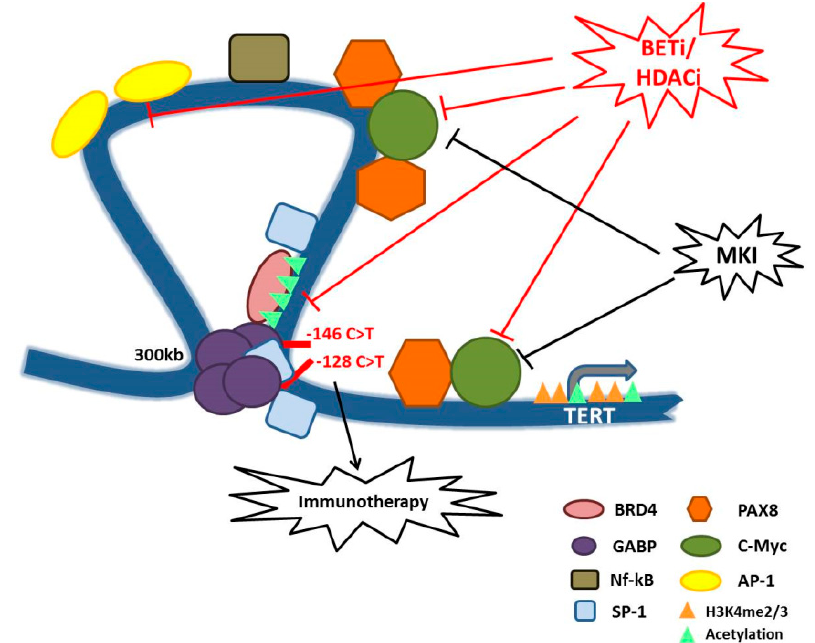
Figure 1. Schematic model representing TERT promoter regulation in TCs and some hypotheses of therapeutic interventions. The figure shows the long-range chromatin interaction mediated by GABP factors and BRD4 on the mutated TERT promoter, and all the transcription factors positively influencing TERT expression and for whom we described a possible connection with TERT promoter in TCs. We also summarized the new proposed therapies for aggressive TCs, that may also rely on telomerase inhibition. In particular, MKI that acts on MAPK signaling and epigenetic drugs such as BETi and HDACi that may counteract TERT expression by impairing the function of TFs such as c-Myc and BRD4. Moreover, telomeres deregulation and the subsequent genomic instability, here represented by TERT promoter mutations, may influence the response to immunotherapeutic treatments. Overall, this model shows that there are many possible therapeutic combinations to counteract the aberrant activity of telomerase in TCs and consequently to inhibit one of the major trigger of TC aggressiveness .